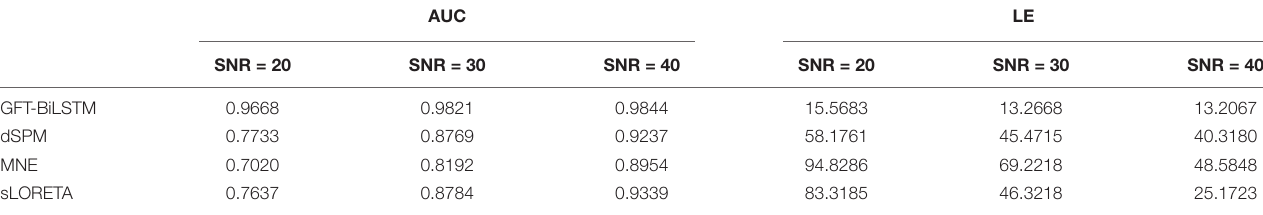
TABLE 1 | The evaluation metrics corresponding to different ESI inverse solutions with a single activated